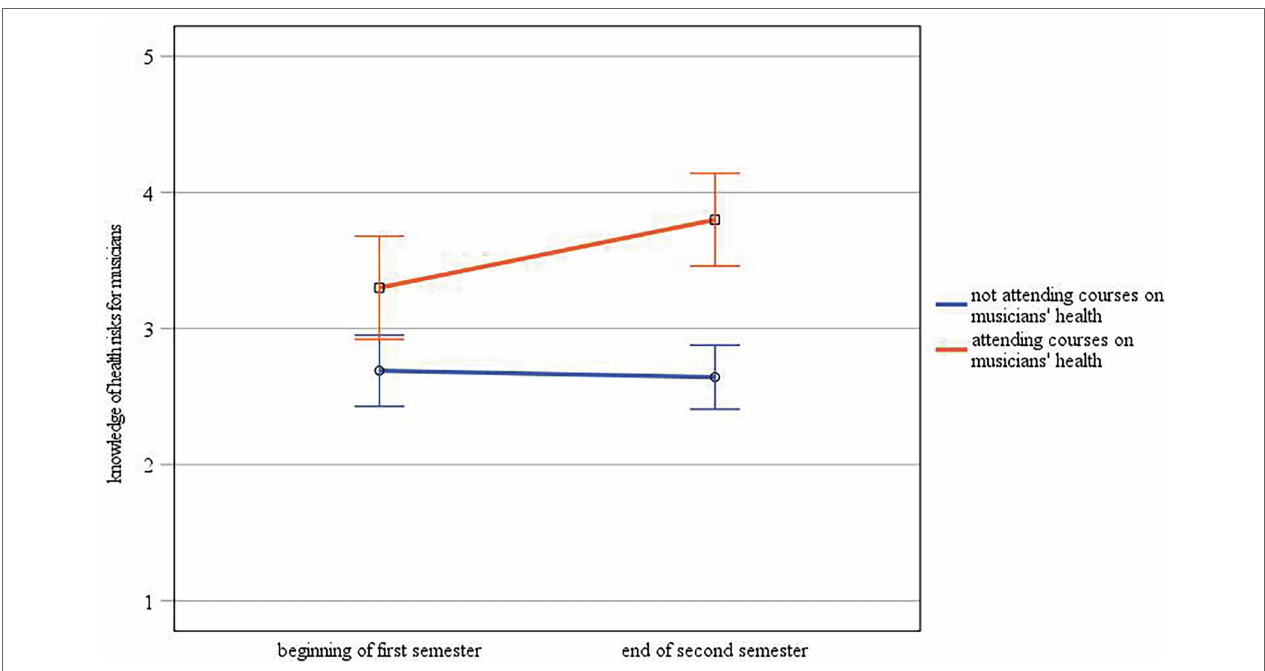
FIGURE 2 | Interaction between time and group regarding self-assessment of knowledge about health risks for musicians (error bars represent 95%